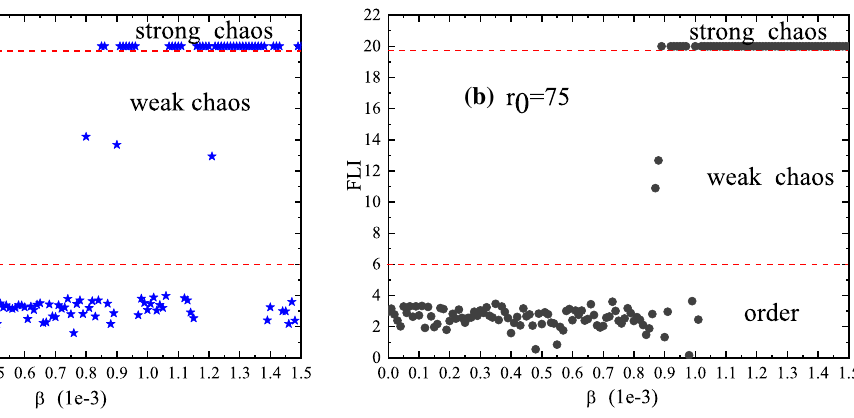
initial values r 0 and p θ > 0 are different. For the strong chaotic case, the integration ends when the FLI reaches 20, whereas the integration time w = 10 7 for the two other cases